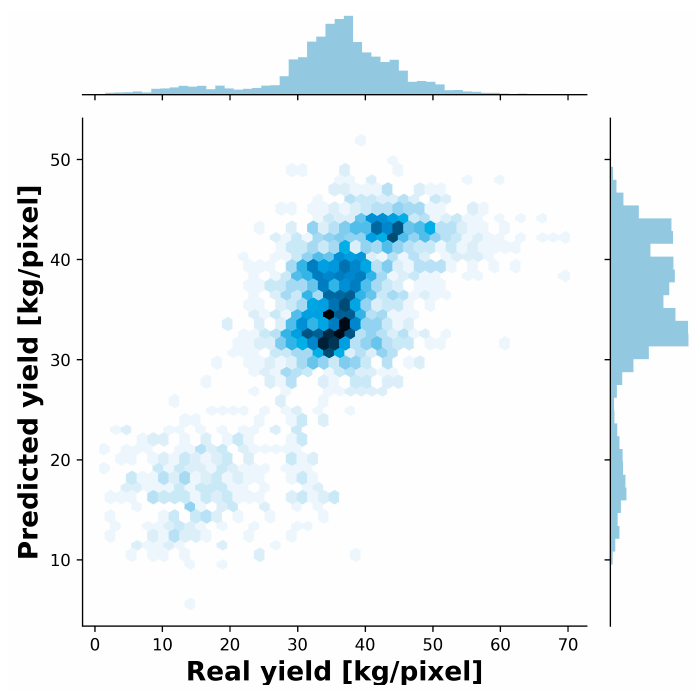
Figure 9. Graph visualization of real and predicted yield on test